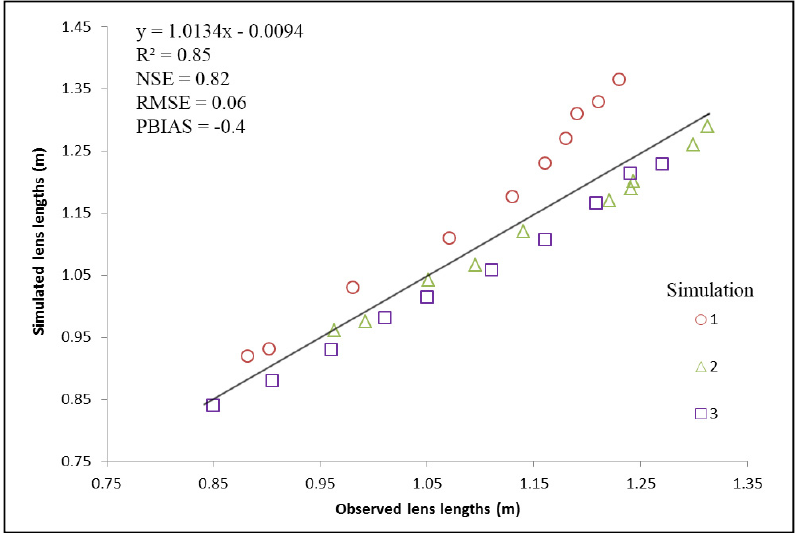
Figure 9. Simulated vs. observed IFL lengths. Table 5. Summary of model evaluation statistics for IFL water table elevation, thickness, and length for Simulations 1, 2, and 3. The evaluation statistics are defined as a measure of fit (R 2 ), the Nash Sutcli ff